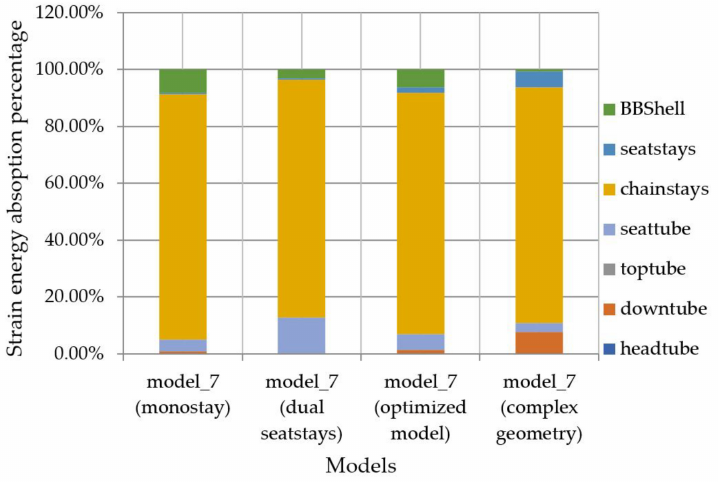
Figure 22. Absorption of strain energy and its distribution in out-of-plane loads on bottom bracket shell